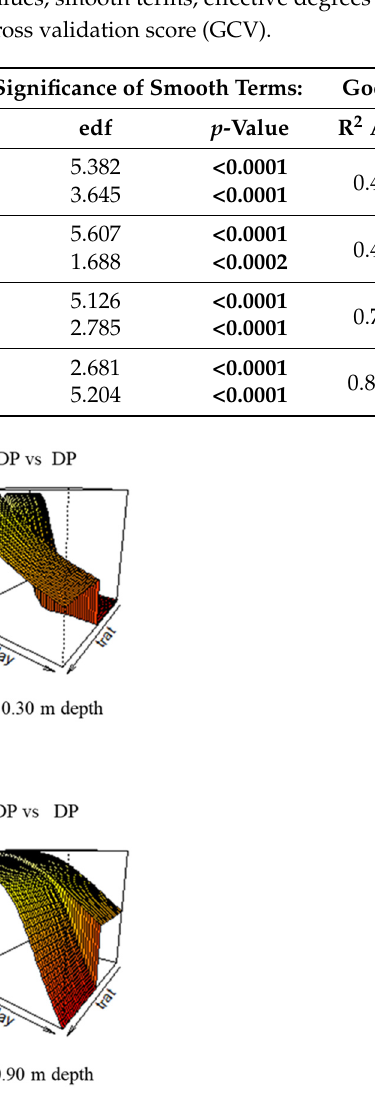
Table 3. GAM models summary statistics, from left to right: depth of the moisture probes, paramet- ric terms, coefficient estimates and relative p -values, smooth terms, effective degrees of freedom (edf), determination coefficient, and generalized cross validation score (GCV).